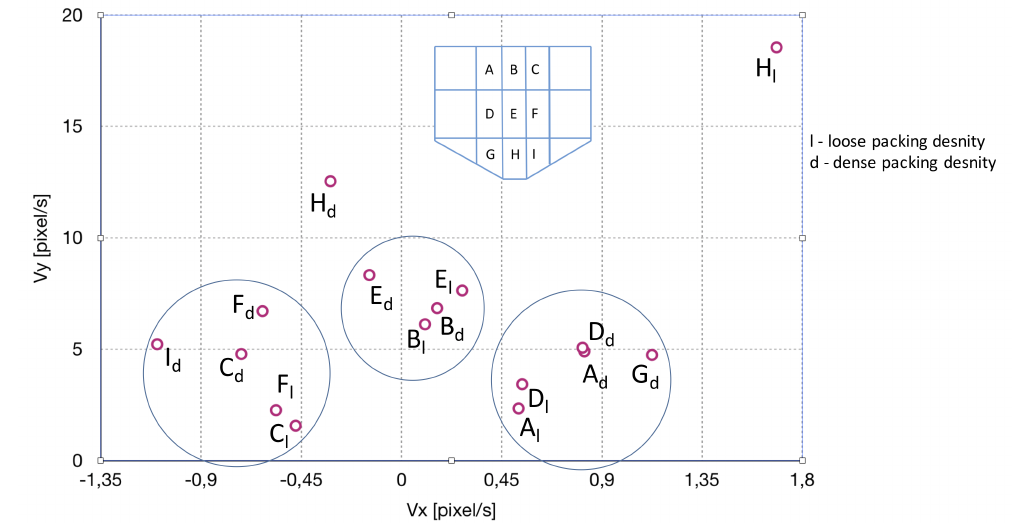
Figure 8. Trace particle-based silo flow velocity distribution map. Small circles show velocity values for distinct silo zones (from A–H), as indicated on a schema drawn in the upper part of the picture. Large circles show groups of similar results. The lower index d indicates the initially dense packing condition, while index l indicates the initially loose packing